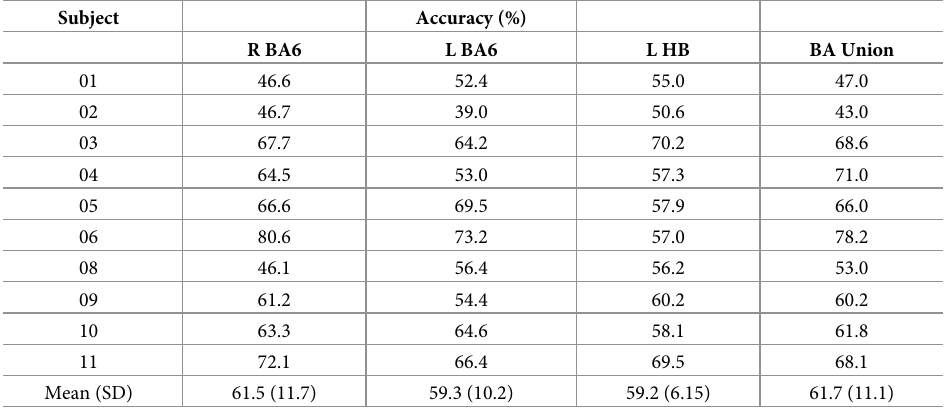
Table 3. Report of the top 3 regional accuracies from participant-specific hemisphere-specific Brodmann’s areas masks, as well as a union of masks consisting of bilateral BA 3, 4, and